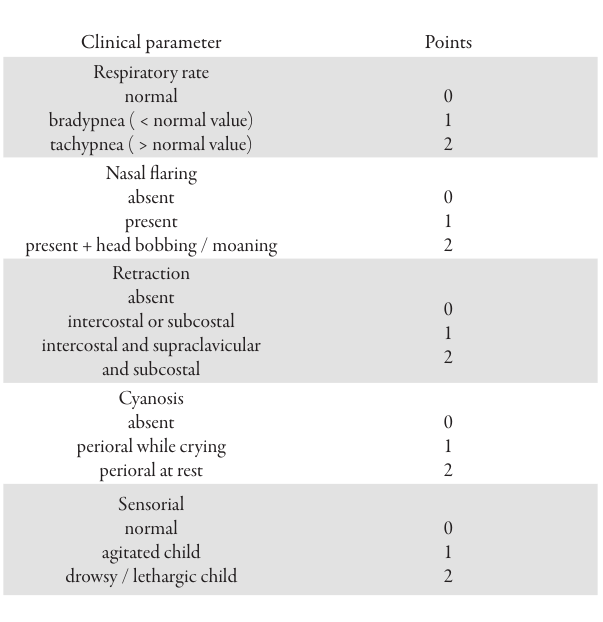
Tab. 1. Clinical appraisal score of respiratory